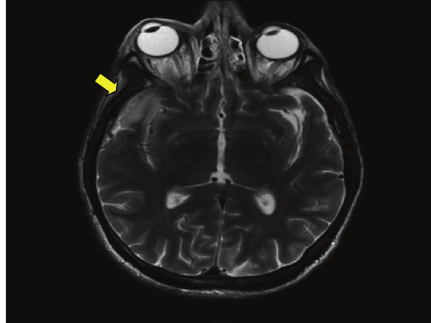
Figure1:Righteyepreseptalcellulitisshowingseverechemosiswith yellowish crust in the eyelids.